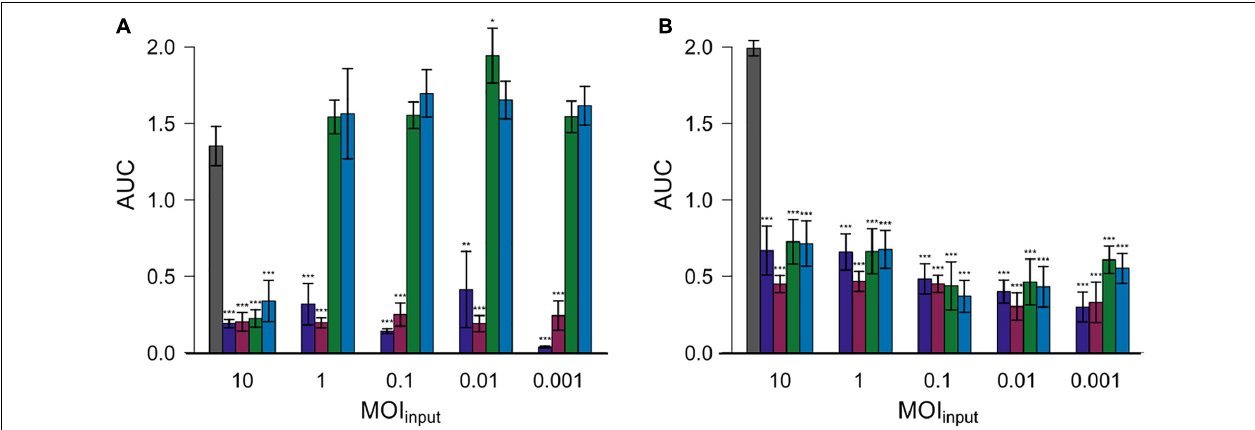
FIGURE 4 | Areas under the curve (AUC) after 26 h for two different Campylobacter isolates. Campylobacter jejuni Cj18 ( A) and LH86 ( B) were exposed to four different phages ( vB_CjM-LmqsCP1-4, vB_CjM-LmqsCP1-5, vB_CjM-LmqsCP74-2c1 and vB_CjM-LmqsCP132-3c) at five different MOI input (10, 1, 0.1, 0.01, and 0.001). The change of optical density over time was recorded. The AUC values were calculated by spline fitting ( t = 0–26 h). Dunnett’s test with a 95% confidence level was used to compare the AUC values of the exposed samples to the untreated comparisons (significance codes indicate range of p -values: *0.01, **0.001, *** > 0.001).